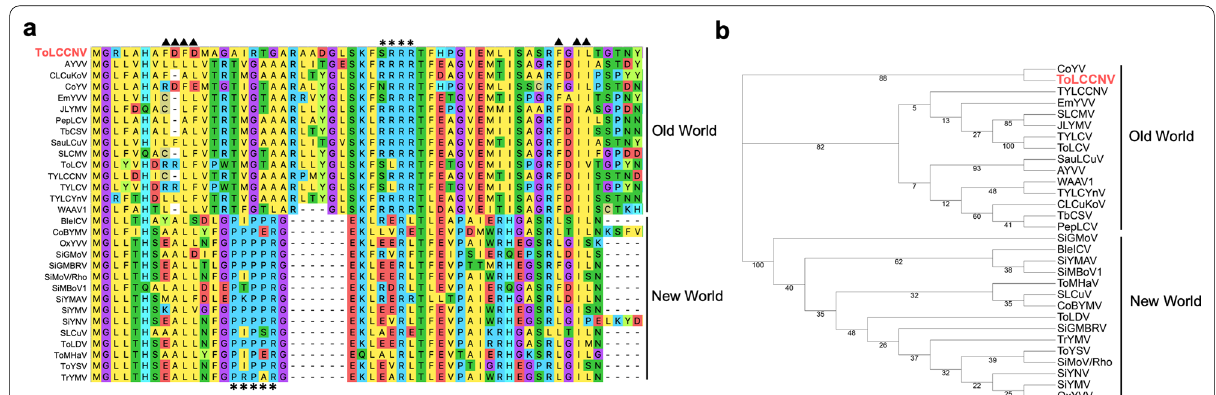
Fig. 2 Sequence analyses of begomovirus‑encoded C6 proteins. a Multiple amino acid sequence alignment of C6 proteins in representative begomoviruses. Asterisks indicate positively charged regions; triangles indicate hydrophobic regions. b Phylogenetic trees constructed based on the amino acid sequences of begomoviruses C6 proteins in a . Bootstrap values (%) for 1000 replicates are indicated. Virus names are shown